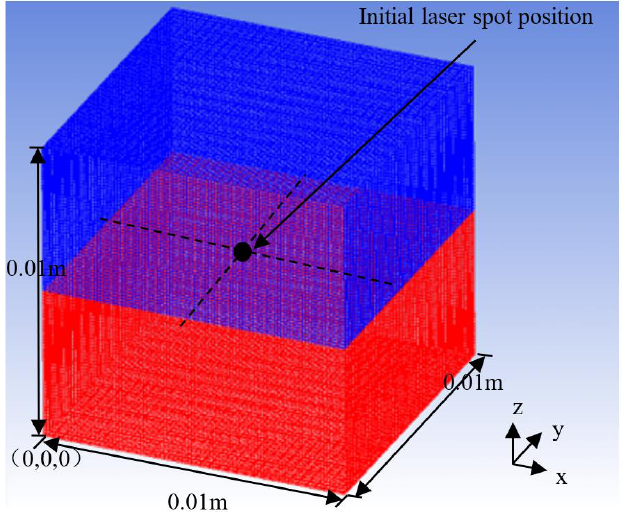
Figure 2. A schematic of calculation domain.